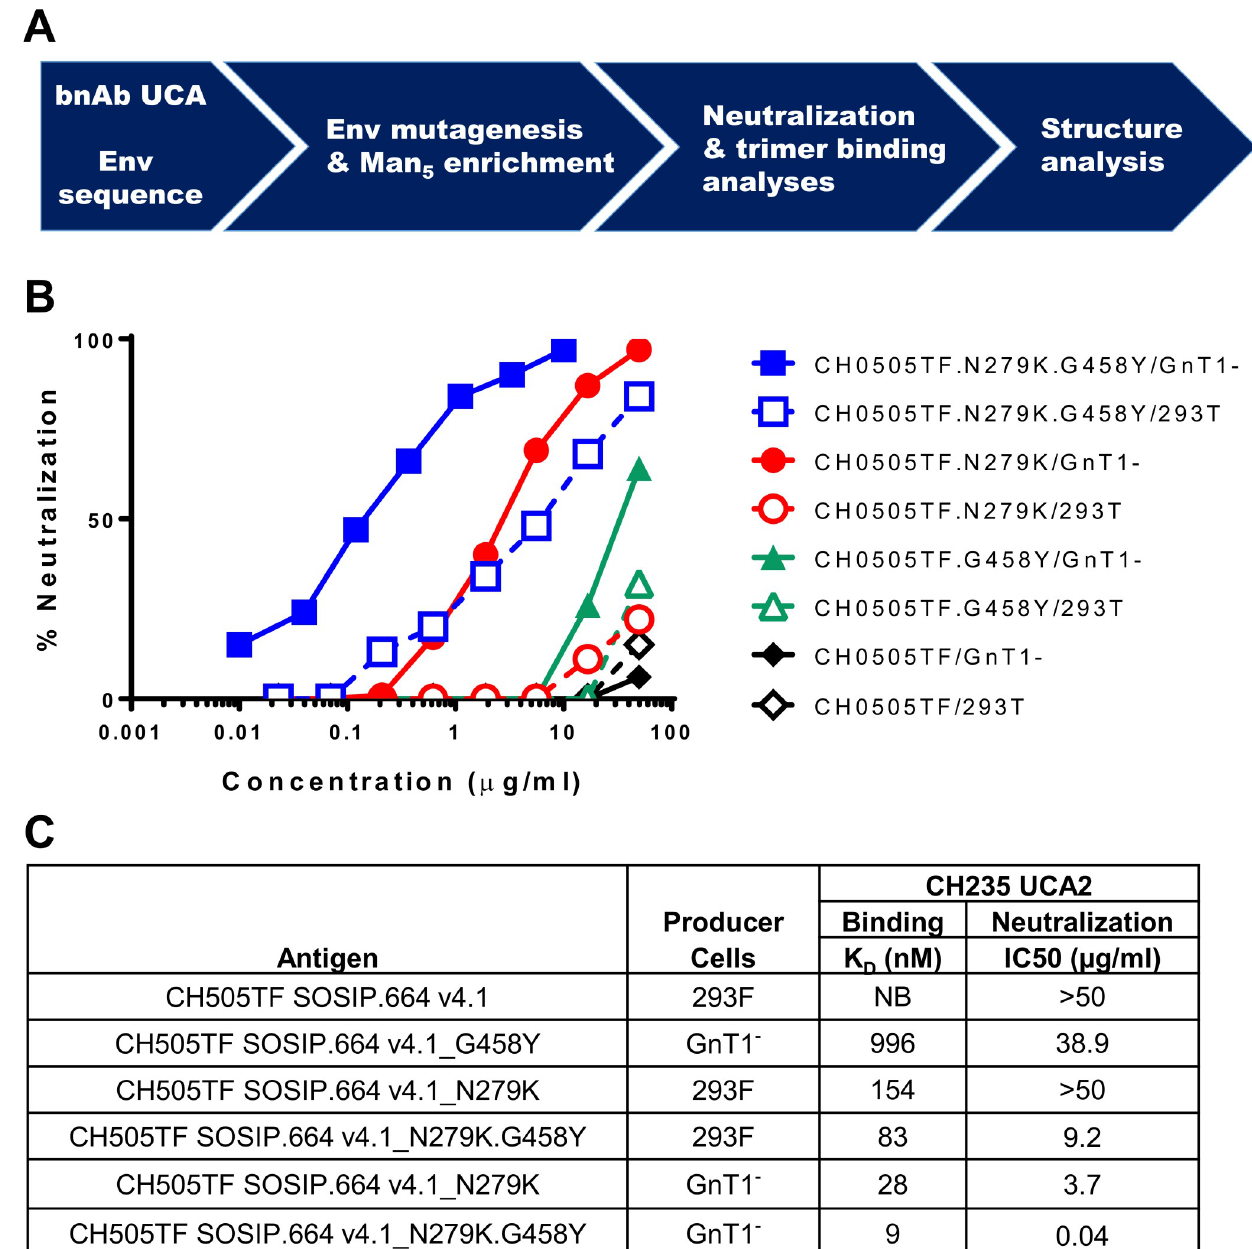
Fig 2. Neutralization by CH235 UCA2 predicts graded binding to corresponding SOSIP trimers. (A) Overall strategy to identify and characterize engineered CH505TF Envs that engage CH235 UCA2. (B) Neutralization of parental and mutant CH505TF Env-pseudotyped viruses produced in either 293T or 293S GnTI - cells and assayed with CH235 UCA2 in TZM-bl cells. Shown are representative curves from S1H Fig. (C) SPR binding of CH235 UCA2 to parental and mutant CH505TF SOSIP trimers produced in either Freestyle293 (293F) or 293S GnT1 - cells. The apparent dissociation rate constant (K D ) values are an average of two measurements (see S3 Fig). NB, no